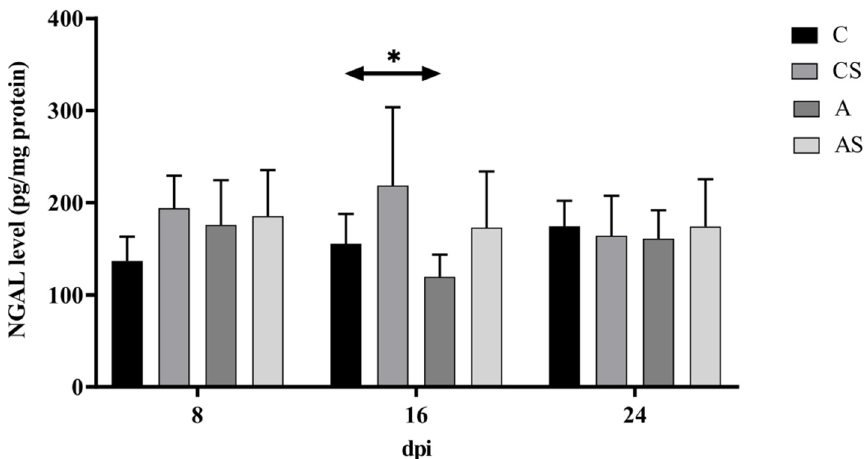
Figure 2. The level of neutrophil gelatinase-associated lipocalin (NGAL) in the kidneys of mice infected with Acanthamoeba spp. NGAL was determined using ELISA and it is expressed in pg/mg protein. Data represent the means ± standard deviation for six independent experiments. (A: Immunocompetent mice infected with Acanthamoeba spp.; AS: Immunosuppressed mice infected with Acanthamoeba spp.; dpi: Days post Acanthamoeba spp. infection; C: Immunocompetent mice uninfected with Acanthamoeba spp.; CS: Immunosuppressed mice uninfected with Acanthamoeba spp.; statistically significant difference * p < 0.05).